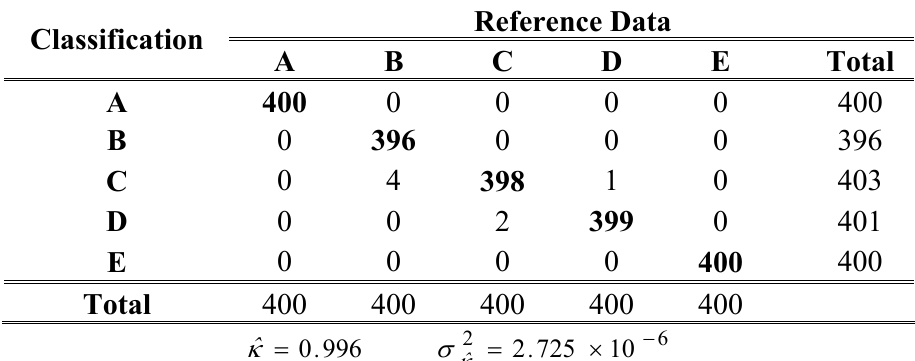
Table 8. Confusion matrix (# of pixels) using the bivariate HH-VV distribution (X-Band).